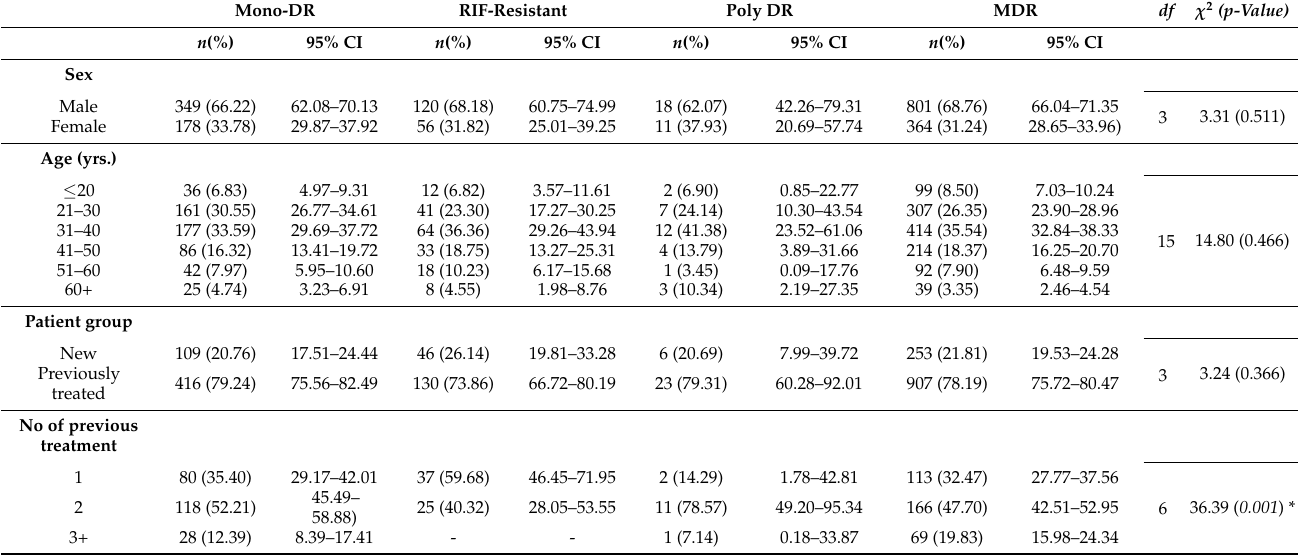
Table 2. Pattern of presentation of bacteriologically confirmed DR-TB cases in Nigeria (2010–2016) ( n = 2555